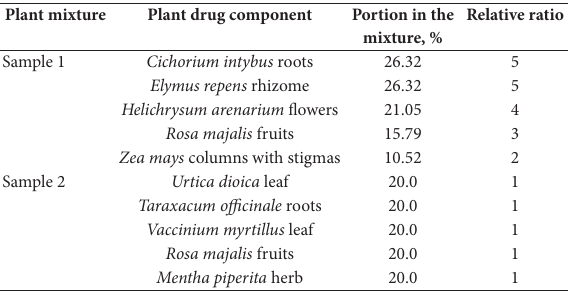
Table 1. Composition of the plant